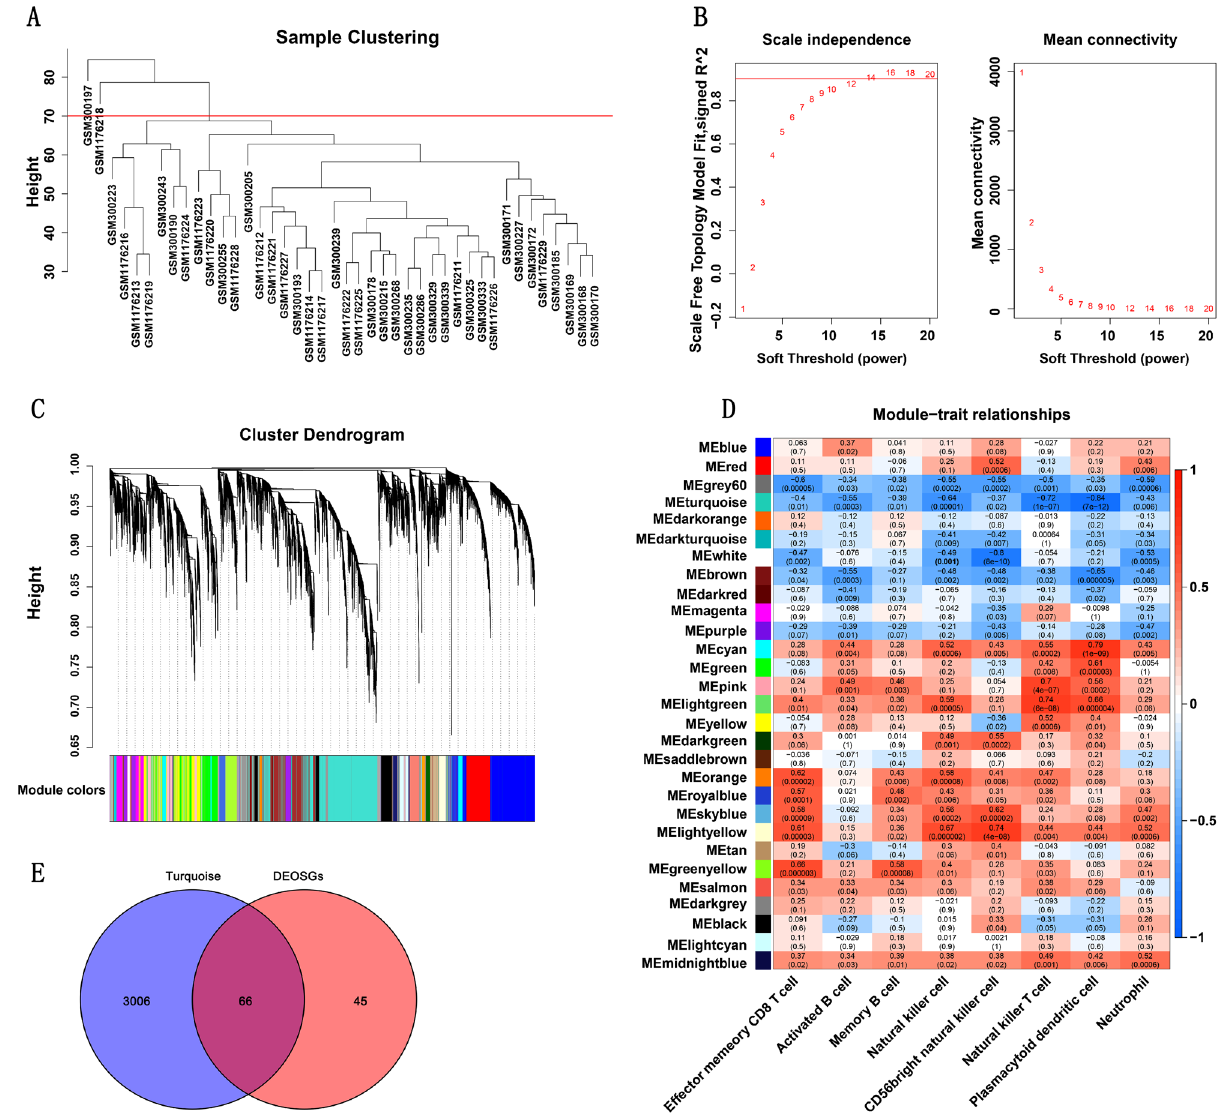
Figure 4. ( A ) A sample dendrogram showed two abnormal samples were removed. ( B ) Analysis of the scale- free fit index and mean connectivity through Scale-free network construction. ( C ) Clustering dendrogram. ( D ) Heatmap of module-trait relationships. The turquoise module was the most relevant module associated with plasmacytoid dendritic cell. ( E ) An overlap of 66 immune-related DEOSGs by intersection of DEOSGs and genes in turquoise